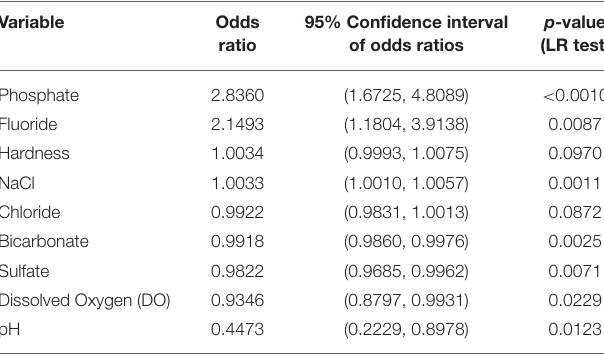
TABLE 4 | Odds ratios, 95% confidence interval, and p -values of model variables.